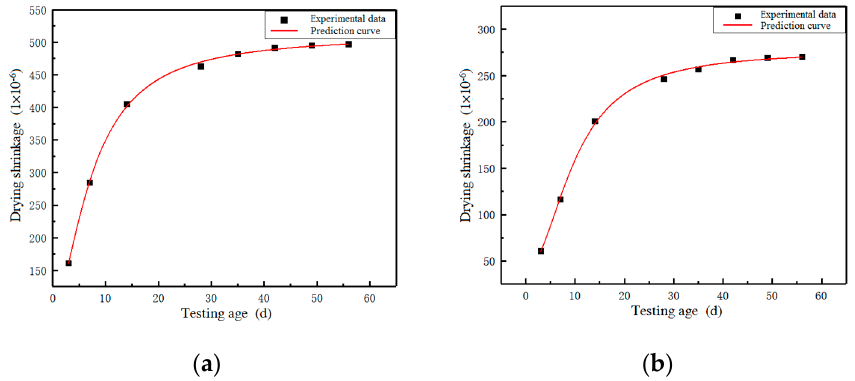
Figure 14. A comparison between the drying shrinkage test results and prediction curve. ( a ) Baseline group; ( b ) 40% substitution rate group.